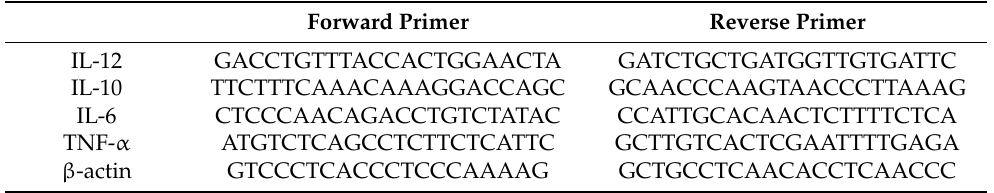
Table 2. The primers used for the cytokine genes of mouse RAW264.7 cells. Forward